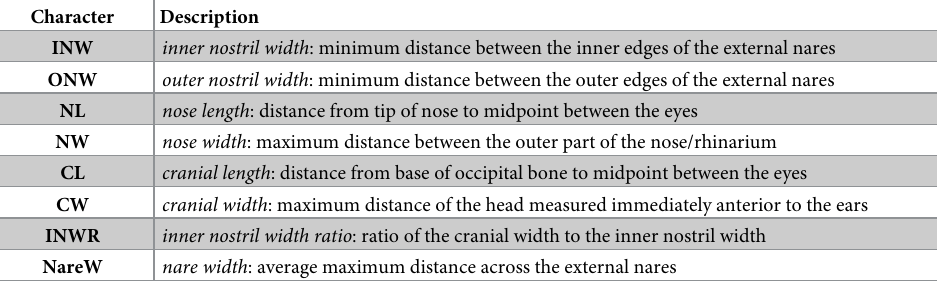
Table 1. Description of morphological